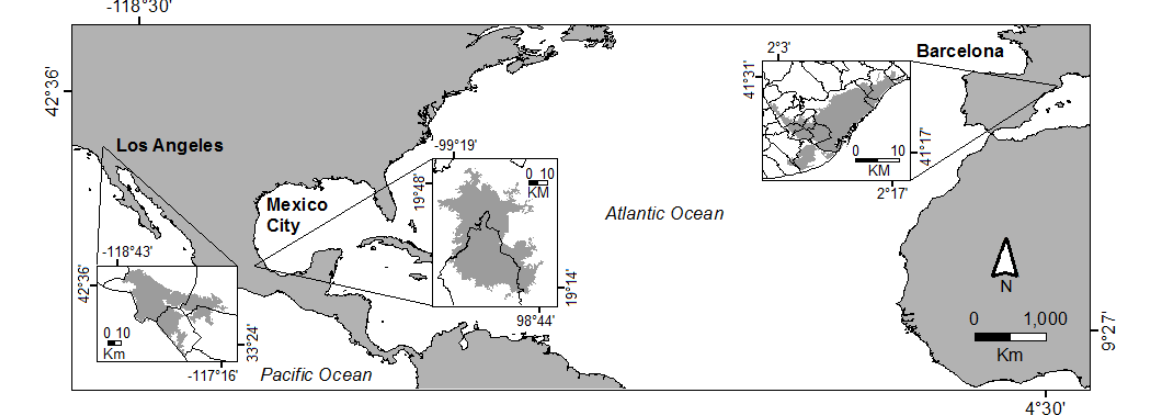
Fig. 1 . Map of the three studied urban-agricultural landscapes. Gray polygons of insets correspond to the urban